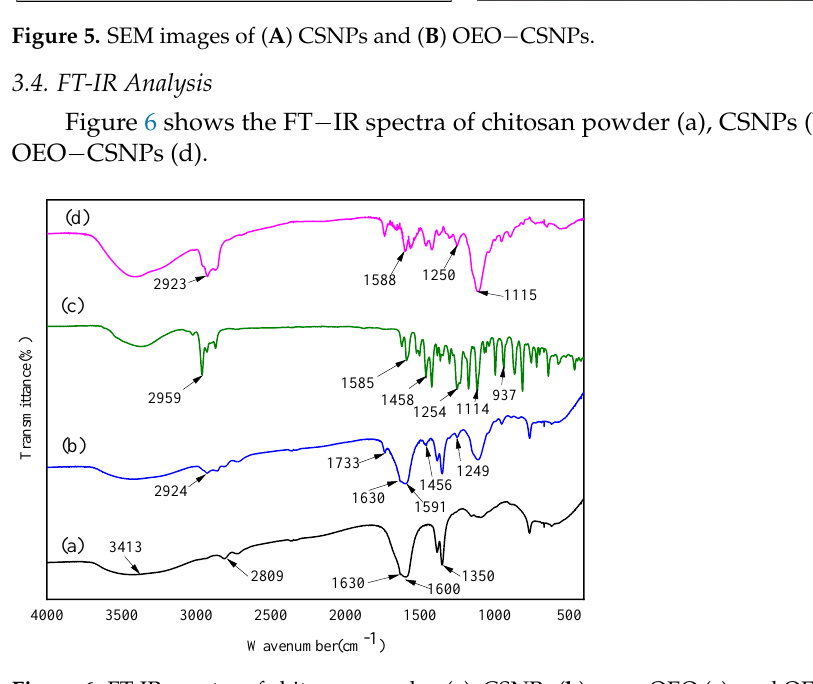
Figure 6. FT-IR spectra of chitosan powder, ( a ), CSNPs ( b ), pure OEO ( c ), and OEO-CSNPs ( d ). The overlap of the -OH stretching vibration absorption peak of hydrogen bonds and -NH 2 stretching vibration absorption peak at 3413 cm −1 indicates the formation of the stretching vibration. Chitosan contains numerous distinct hydrogen bonds: a broad peak range at 2809 cm −1 (-CH stretching), and three characteristic absorption peaks of amino polysaccharides: 1634 cm −1 (amide I, C=O stretching), 1600 cm −1 (amide II, N-H bending), and 1350 cm −1 (amide III, N-H bend) (Figure 6a) [30]. As shown in Figure 6c, the cross-linking of chitosan and TPP is expected to shift some of the amide group-related peaks, with the peak at 1634 cm −1 shifting to 1630 cm −1 and the peak at 1600 cm −1 shifting to 1591 cm −1 , confirming the occurrence of ionic cross-linking reaction [30]. Similar results were obtained by Matshetshe et al. [29] studying the interaction between chitosan and TPP. In addition, the appearance of 1249 cm −1 (C-O-C stretching), 1456 cm −1 (amide II), and 1733 cm −1 (C=O stretching) may be attributed to electrostatic interaction [15]. The absorption peaks of oregano essential oil (Figure 6d) are 2959 cm −1 (-OCH 2 stretching), 1589 cm −1 (N-H bending), 1458 cm −1 (CH 2 , bending), 1254 cm −1 (C-O-C stretching), 1117 cm −1 (C-O-C stretching), and 937 cm −1 (-CH bending) [42]. The above characteristic ab- sorption peaks appear at the same wavenumber, and the OEO significantly increases the intensity of the C-H stretch peak at 2867 – 2955 cm −1 , as shown in Figure 3e at 2923 cm −1 . Strong C-H stretching vibration peaks indicate that the OEO ester functional groups are encapsulated within the nanoparticles [36]. These findings are in agreement with the results of Esmaeili et al. [30], Seyed et al. [34], and Hesami et al. [40]. The results showed that OEO was encapsulated in CSNPs without changing its structure or function, indi- cating that its antibacterial and antioxidant properties remained intact. 3.5. TGA Analysis TGA analysis is a thermal analysis technique that measures the relationship between the mass of the test sample and the change in temperature at a specific pro- gram-controlled temperature [36]. The TGA thermograms in Figure 7 revealed mass loss as a function of temperature for the chitosan powder (a), CSNPs (b), OEO (c), and OEO − CSNPs (d). OEO begins to decompose at approximately 68 °C in the nitrogen en- vironment and loses approximately 92.54% of its mass by 170 °C, which fully reflects the volatile characteristics of essential oil core material [43]. This is similar to the results of Seyed et al. [42] studying the weight loss of OEO. In contrast, the wall material has higher stability. At 243 °C, chitosan undergoes its initial degradation, resulting in a mass loss of